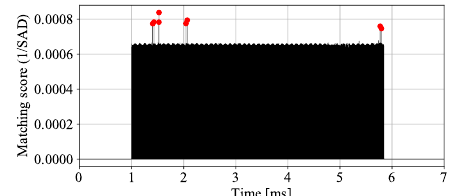
ing method (cf. Figure 10).